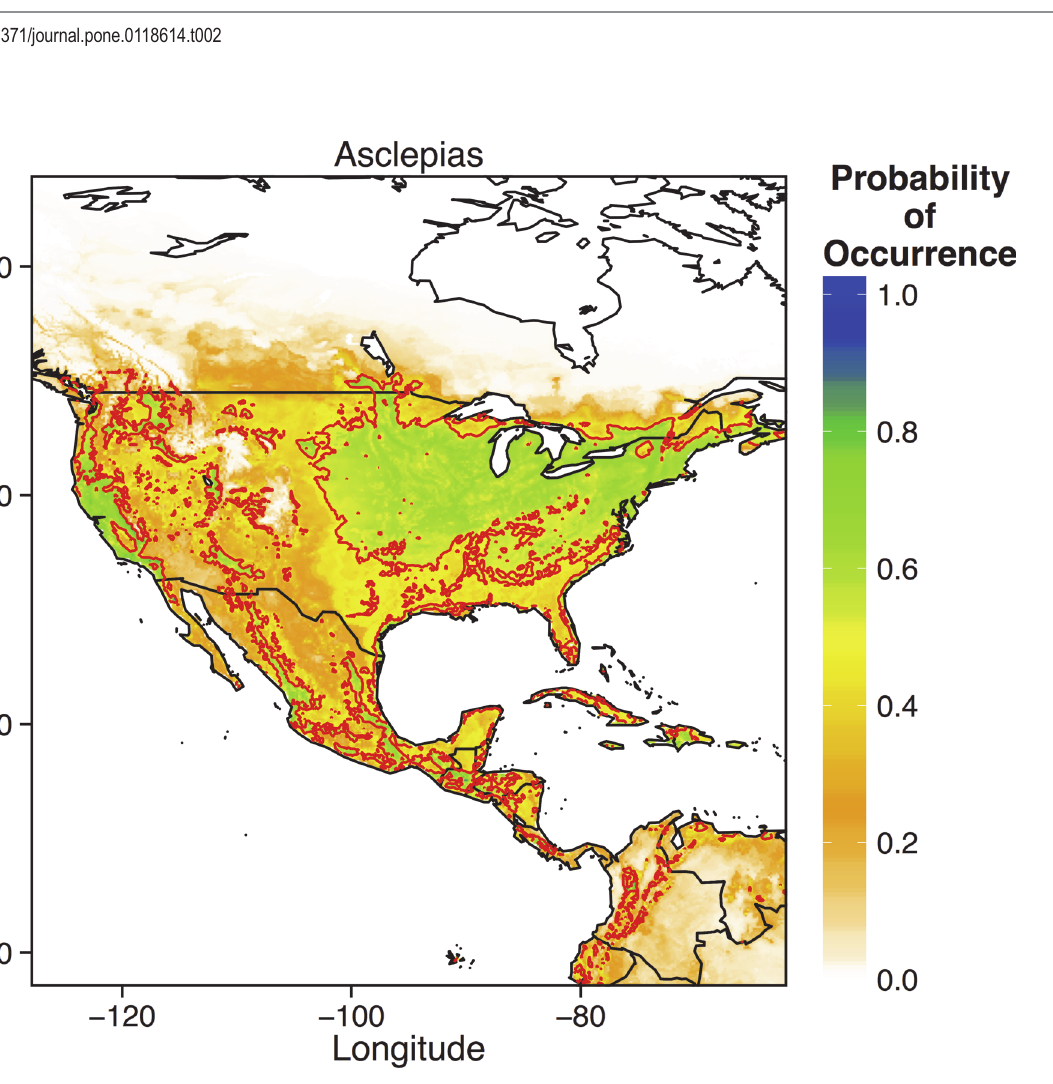
Fig 2. Prediction from the best-fitting MaxEnt model for the probability of occurrence of the overall Asclepias distribution across North, Central, and parts of South America. Thick red lines denote the 0.5 probability contour, such that areas inside the contour have a (cid:1) 0.5 probability of containing Asclepias